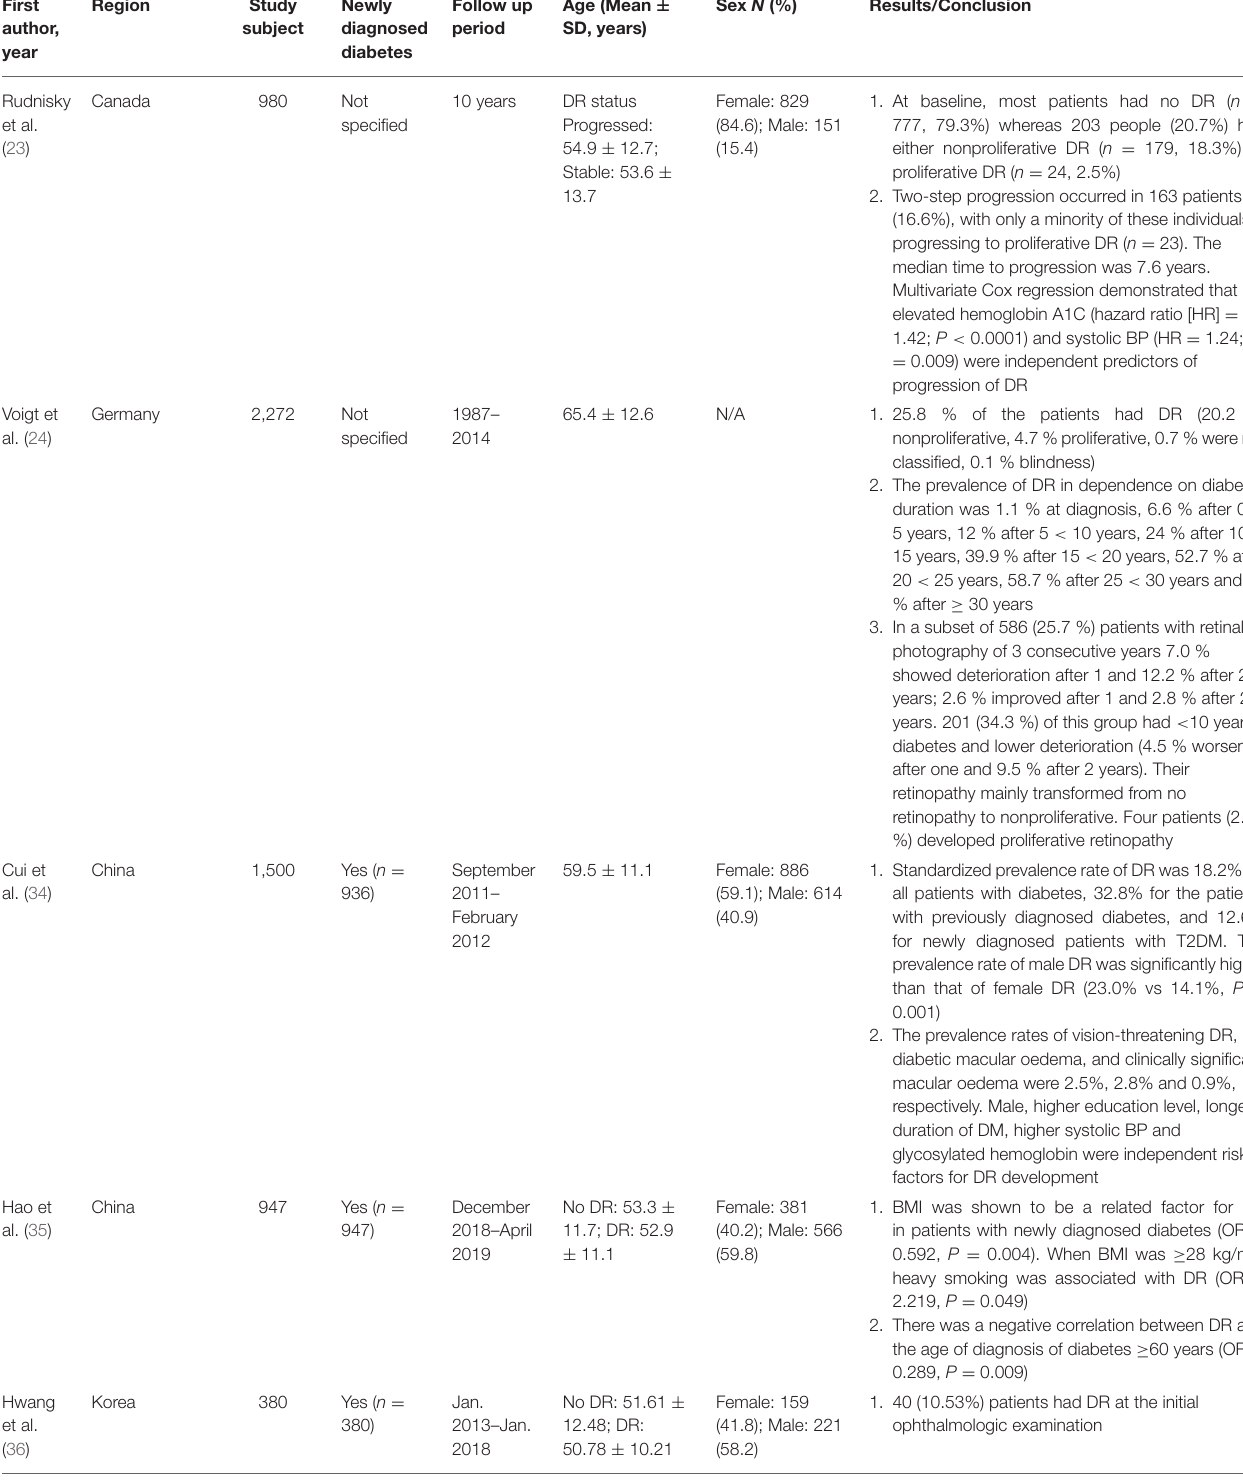
progressing to proliferative DR ( n = 23). The median time to progression was 7.6 years. Multivariate Cox regression demonstrated that elevated hemoglobin A1C (hazard ratio [HR] =